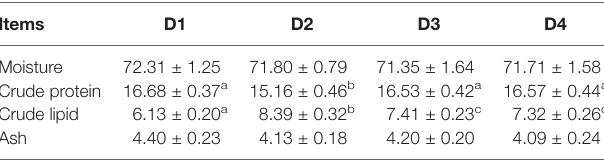
TABLE 4 | Effects of L-carnitine on whole body composition (% wet weight) of Trachinotus ovatus